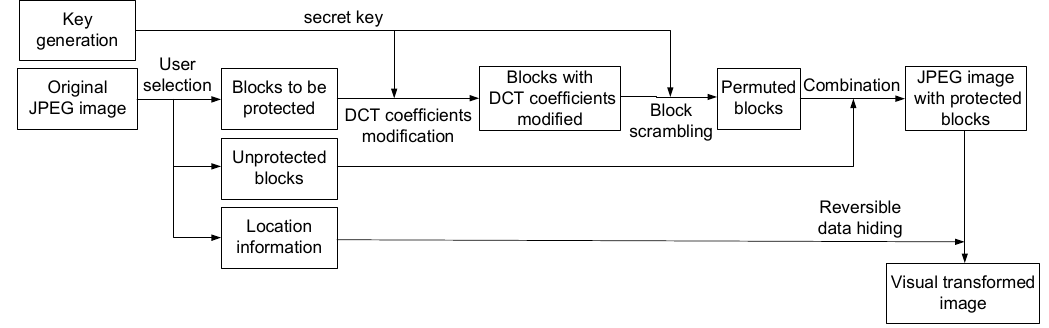
Figure 1. A flowchart of visual transformation for content and privacy protection in JPEG images.